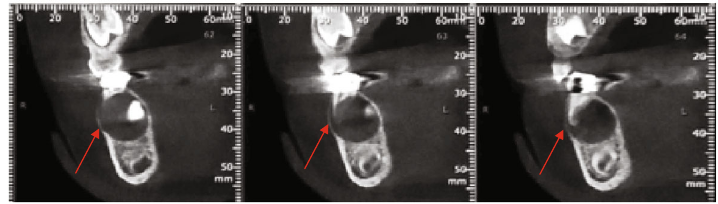
Figure 5: Coronal sections showing a well-de fi ned radiolucent lesion surrounding the crown of the unerupted fi rst premolar (# 44) (red arrow).